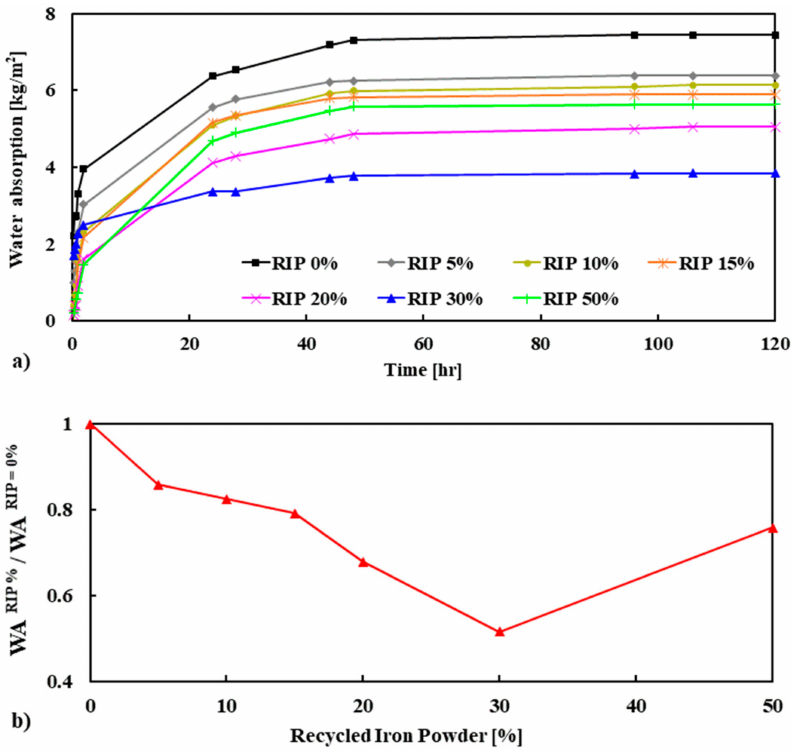
Figure 10. Capillary water absorption (WA) ( a ) and normalized WA ( b ) of mortar specimens.